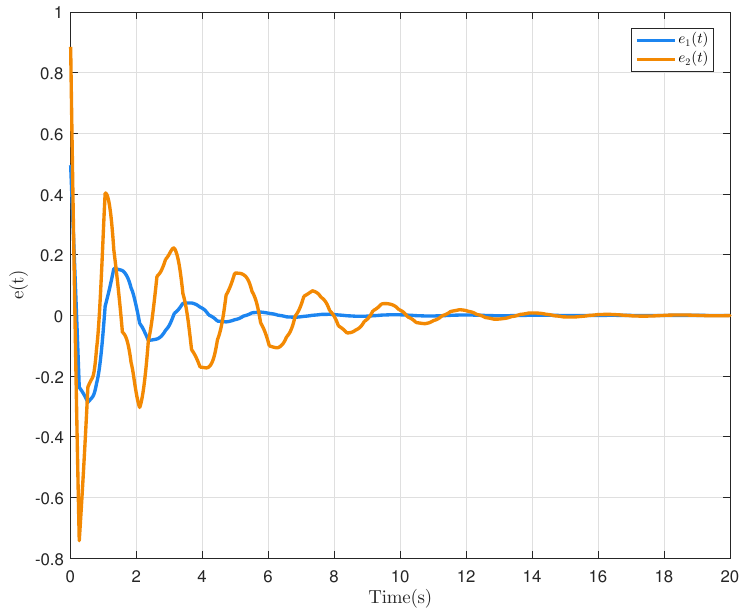
Figure 5. State responses of the error